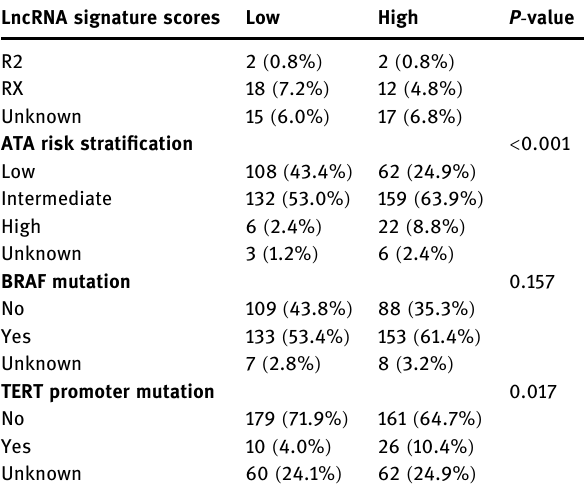
Table 4: Comparison of the clinical characteristics between the patients with low and high - risk